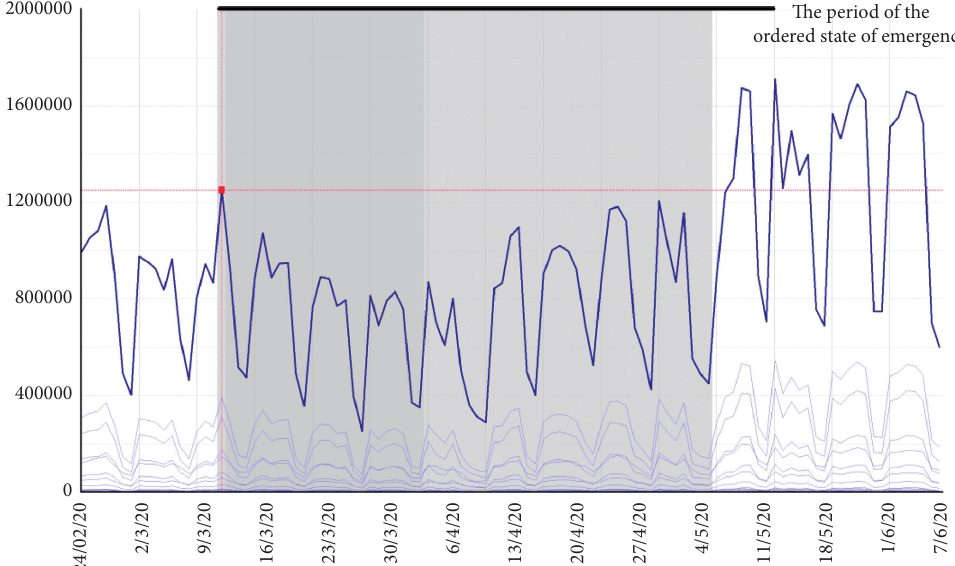
Figure 4: The number of measurements from 24 February to 7 June 2020.